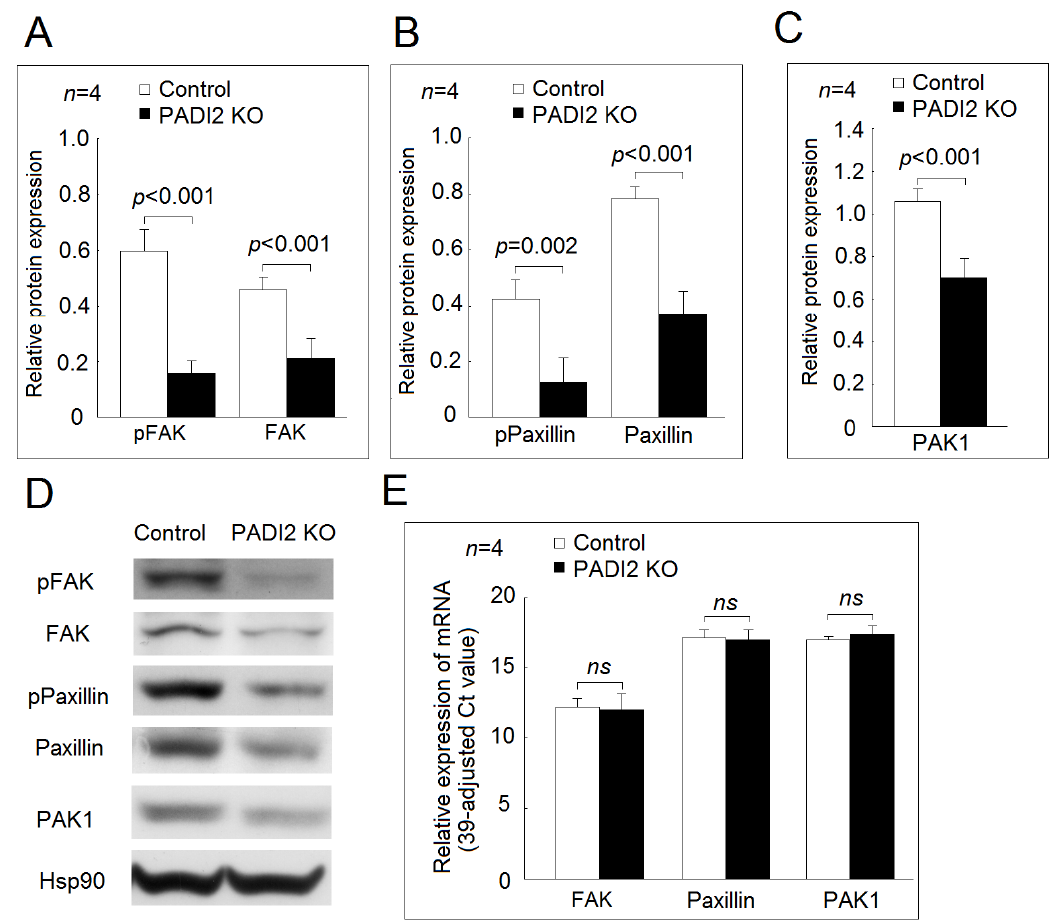
Figure 6. E ff ects of PADI2 knockout in the protein and mRNA expression of FAK, paxillin , and PAK1 in the di ff erentiated macrophages: ( A ) comparison of the relative protein expression levels of FAK and phospho-FAK in the PADI2 knockout group and the control group; ( B ) comparison of the relative protein expression levels of paxillin and phospho-paxillin in the PADI2 knockout group and the control group; ( C ) comparison of the relative protein expression levels of PAK1 in the PADI2 knockout group and the control group; and ( D ) Representative images showing the relative protein expression levels of FAK, paxillin, and PAK1 in the PADI2 knockout group and the control group; ( E ) the relative mRNA expression levels of FAK , paxillin , and PAK1 . In di ff erentiated macrophages, the protein expression levels of the cell adhesion-related proteins including FAK, phospho-FAK, paxillin, phospho-paxillin, and PAK1 were performed by Western blotting in the PADI2 knockout group and the control group. The relative protein expression was defined as the ratio of a specific protein / hsp90 band intensity.